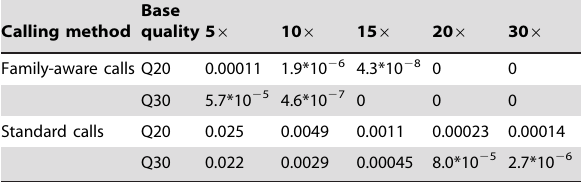
Table 3. Mendelian inconsistency rates per triplet (father, mother and offspring) for the genotypes by joint modeling of family data (top panel) and by the standard approach where the relatedness was ignored, i.e. individuals were treated as unrelated (bottom panel) for sequencing coverage of 5 6 to 30 6 and bases with Phred-scaled quality Q20 (1% error rate) and 30 (0.1% error rate) without mapping